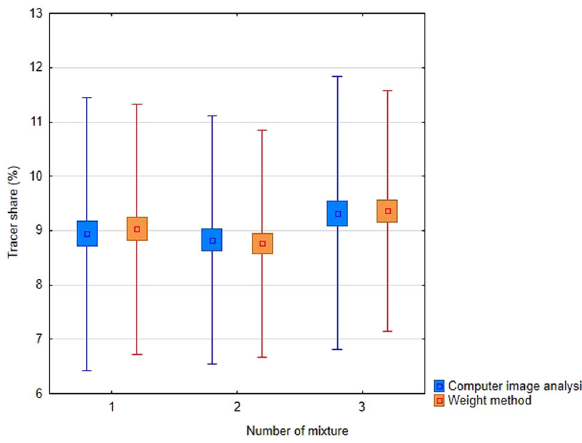
Figure 3: A box plot graph of the share of the tracer ( maize d = 1.25 mm ) obtained by two methods for the three mixtures analyzed ( point: mean, box: mean ± standard error, whiskers: mean ± 2 × standard deviation )